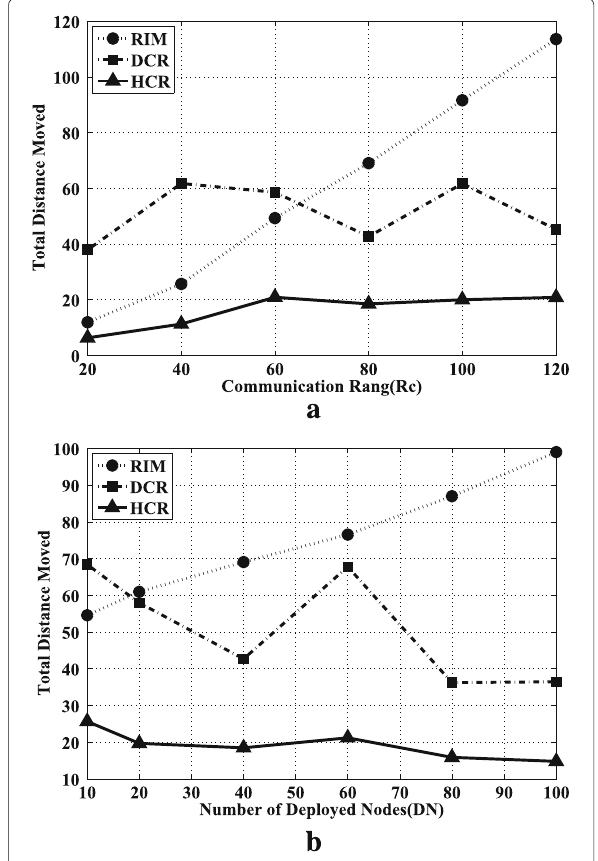
Fig. 10 The total moved distance during the restoration while varying a the communication range (with DN = 40), and b the network size (with R c =